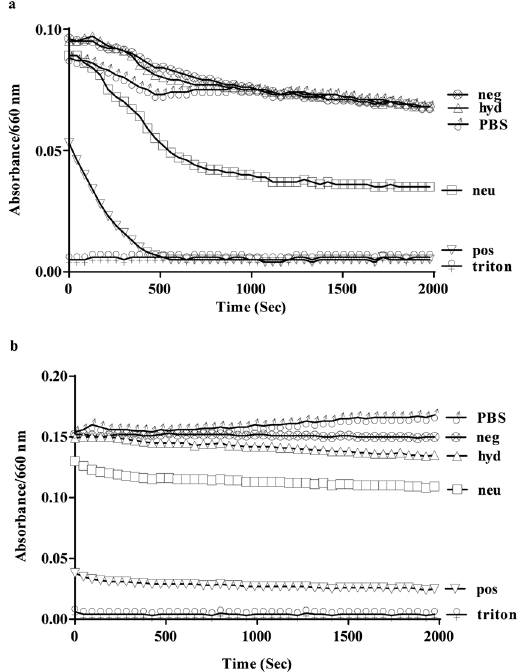
Figure 4. Lipid solubilization assay. ELKs dissolved in PBS or just PBS were continuously mixed with 0.1 mg/ ml DMPC ( a ) and a mixture of natural lipids ( b ). Turbidity was monitored by measuring the absorption at 432 nm every 5 seconds for 50 min and changes were expressed relative to H 2 O. A sample with 1% Triton X-100 and an untreated sample were included in ( a ) and ( b ) as positive and negative control, respectively, and used to calculate %